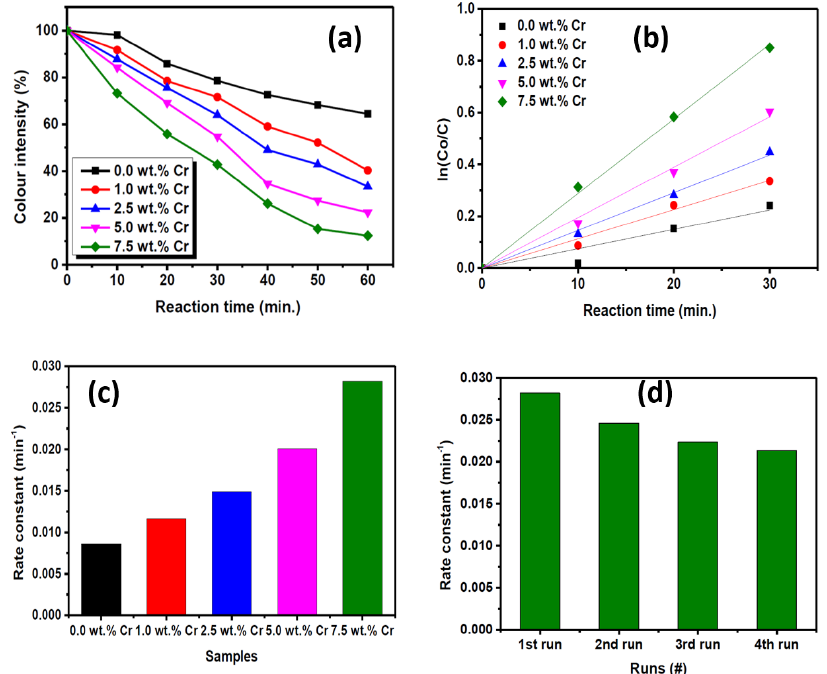
Figure 5. ( a ) The change in MG concentration during the photocatalysis experiments over the pre- pared Cr-doped ZnO samples, ( b ) the pseudo first-order kinetic model of the photocatalytic exper- iments, ( c ) the calculated rate constants of the prepared samples, and ( d ) the reusability investiga- tion of the prepared 7.5 wt.% Cr sample.